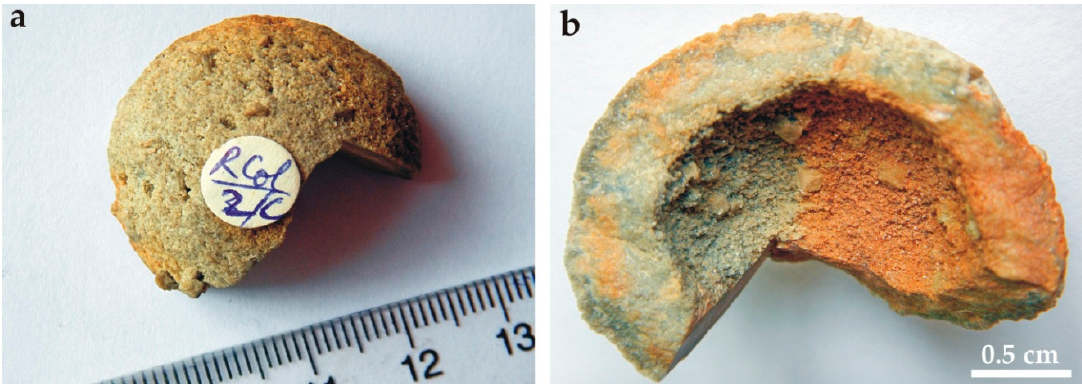
Figure 8. Siderite hollow sphere from Herja (sample RCol 2 / C; MMBBU). ( a ) External view of broken siderite sphere; ( b ) Inner view of the sphere with euhedral rhombohedra siderite crystals deposited on the interior wall of the sphere; note the variation of the width of the sphere’s wall.